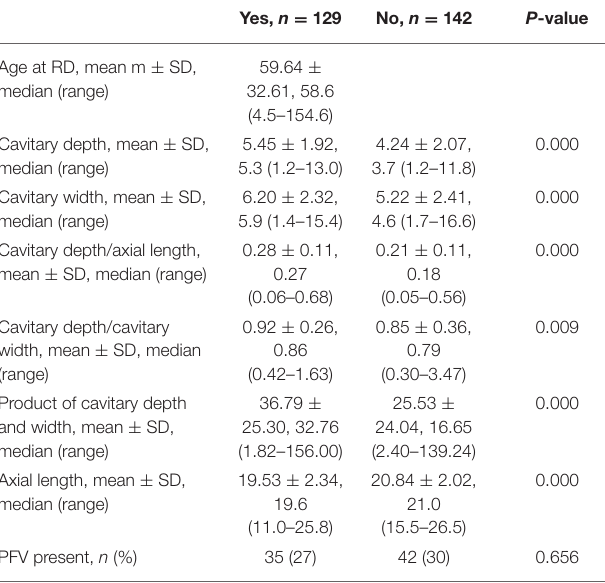
TABLE 5 | Demographic, echographic, and structural characteristics of eyes with and without retinal